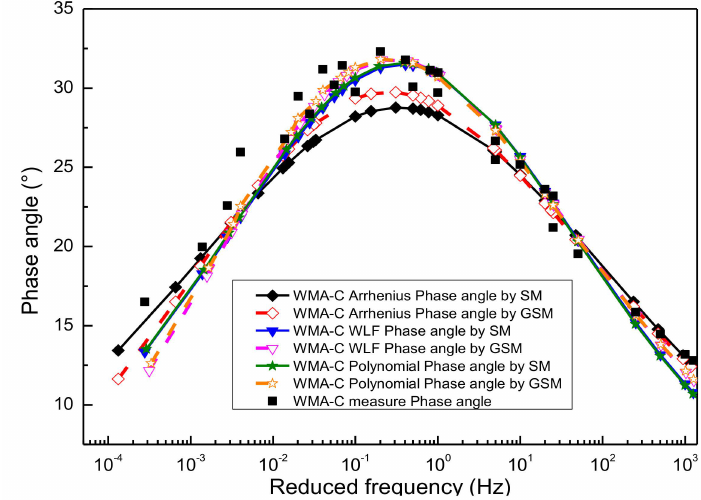
Figure 15. Compared phase angle master curve obtained by di ff erent